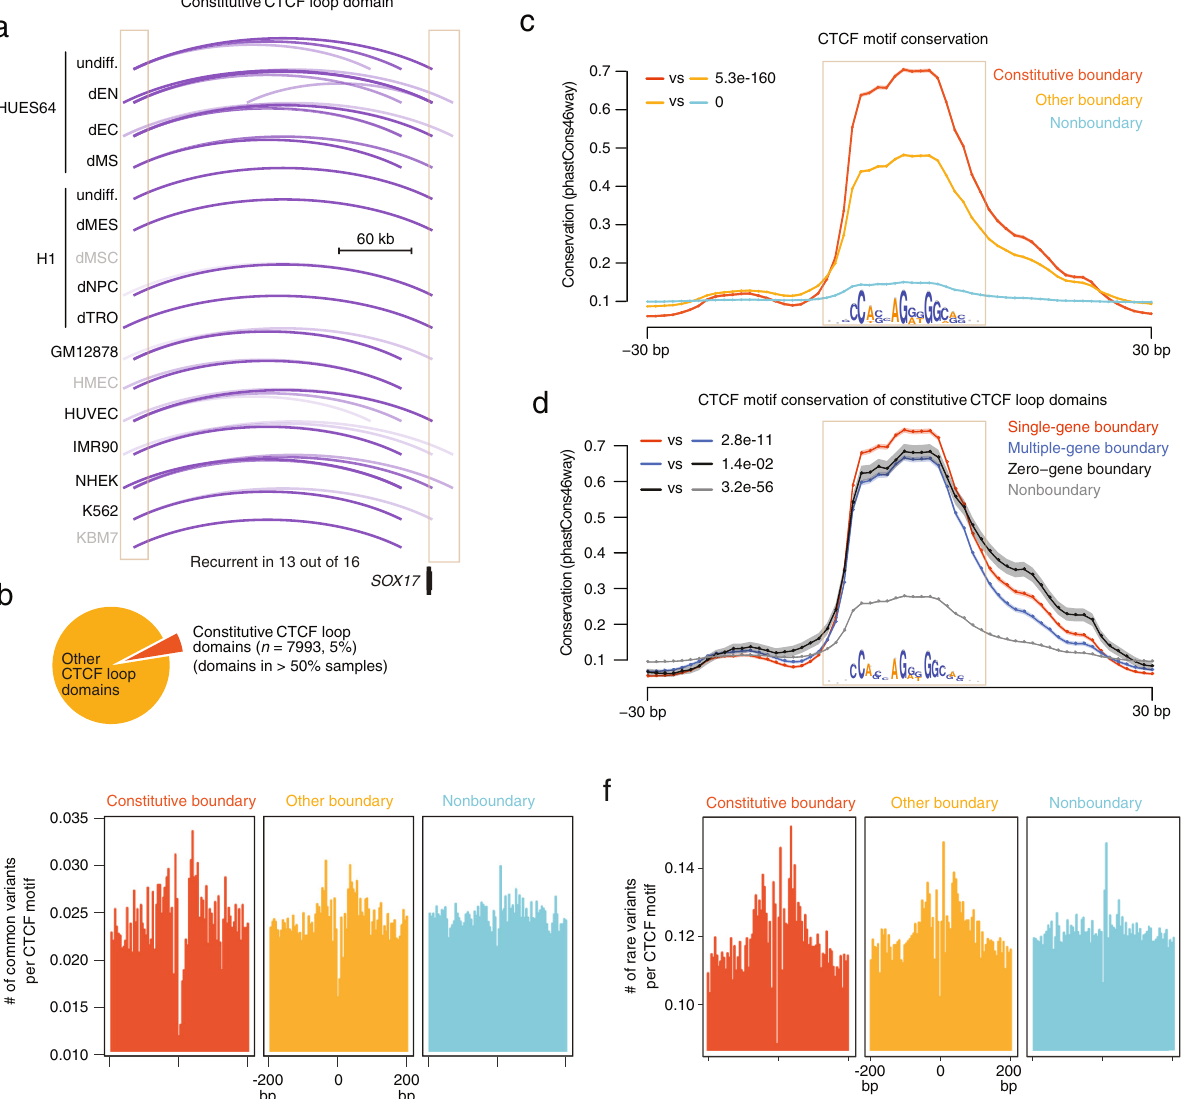
Fig. 6 A functionally essential role of constitutive CTCF loop domains. a Display of a constitutive domain at the SOX17 locus that is conserved across 13 out of 16 human cell types. Arcs represent the domains in different cell types. The constitutive boundaries are shown via the box. b The pie plot shows the proportion of constitutive domains and domains. Constitutive domains are present in >50% of samples, while domains are present in ≤ 50% of samples. c Evolutionary conservation of consensus CTCF motifs at constitutive domain boundaries, domain boundaries, and nonboundaries. Nonboundary CTCF motifs are those motifs not in any domain boundaries. The motif region is shown in the box and the motif sequence is displayed. The average conservation score across placental mammals across all boundary regions is shown. The shaded area indicates the standard error. Two-sided Wilcoxon test P -values tested in the motif regions are shown. Data are presented as mean values ± SE. d Evolutionary conservation of consensus CTCF motifs at single-gene, multi-gene, and zero-gene boundaries of constitutive domains and nonboundaries. Nonboundary CTCF motifs are the motifs not in any constitutive domain boundaries. See more descriptions in c . Data are presented as mean values ± SE. e The number of common variants per consensus CTCF motif site at constitutive domain boundaries, domain boundaries and nonboundaries. Common variants are genetic variants with an allele frequency larger than 1% in the 1000 genome project phase 3 data. f The number of rare variants per consensus CTCF motifs at constitutive domain boundaries, domain boundaries, and nonboundaries. Rare variants are genetic variants with allele frequency less than 1% in 1000 genome phase 3